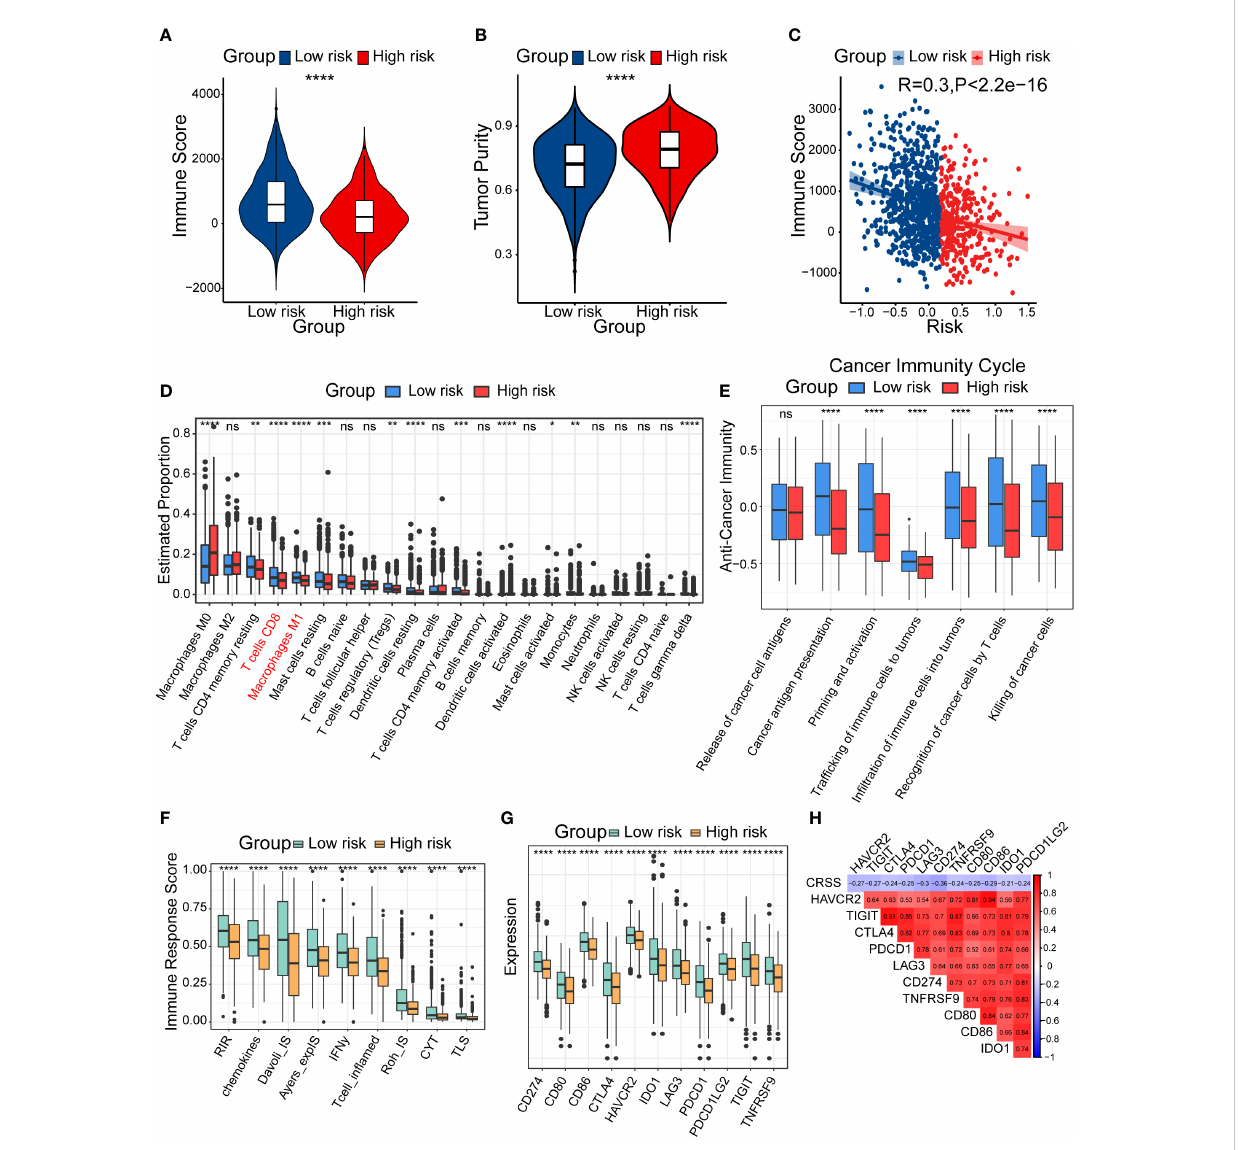
FIGURE 5 Diverse tumor immune microenvironments among high/low-risk patients. (A) Immune score in high/low-risk subgroups. (B) Tumor purity in high/low- risk subgroups. (C) Spearman correlation between Immune score and CRSS. (D) The differential estimated proportion of 22 CIBERSORT immune cell types in high/low-risk subgroups. The central line represents the median value. The bottom and top of the boxes are the 25th and 75th percentiles (interquartile range). The whiskers encompass 1.5 times the interquartile range. (E) Activities of seven-step cancer immune cycle. (F) Immune response score in high/low-risk groups. (G) The expression of immune-related checkpoints genes among high/low-risk subgroups. (H) Correlations between CRSS and expression of immune-related checkpoints genes. The asterisks represent the statistical P value (*p < 0.05; **p < 0.01; ***p < .001; ****p < 0.0001; ns p >